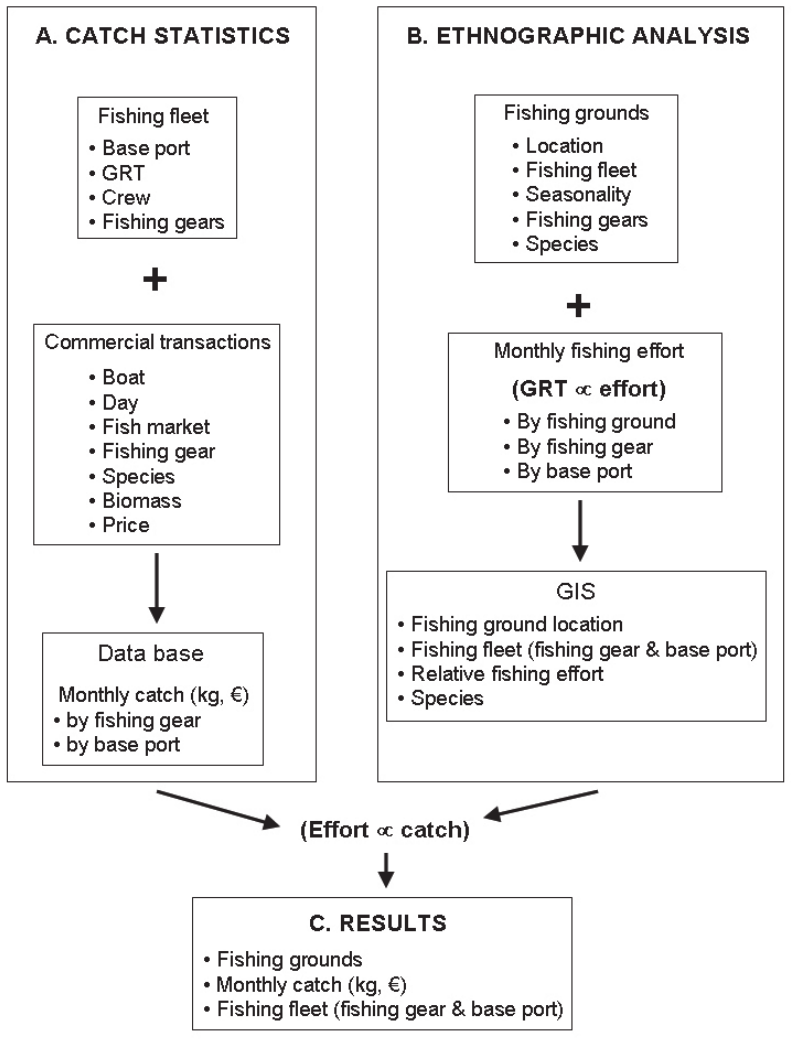
Fig . 2. – outline of the methodology developed to obtain a spatial allocation of the catch of a fishing fleet from fishing statistics without a geographic location for the